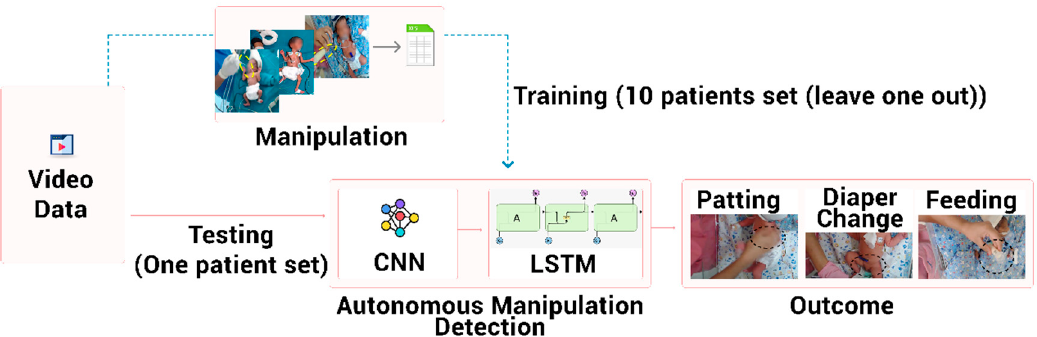
Figure 4. Deep learning architecture for neonatal video classification utilizing Convolutional Neural Network (CNN) and Long Short Term Memory (LSTM) network.